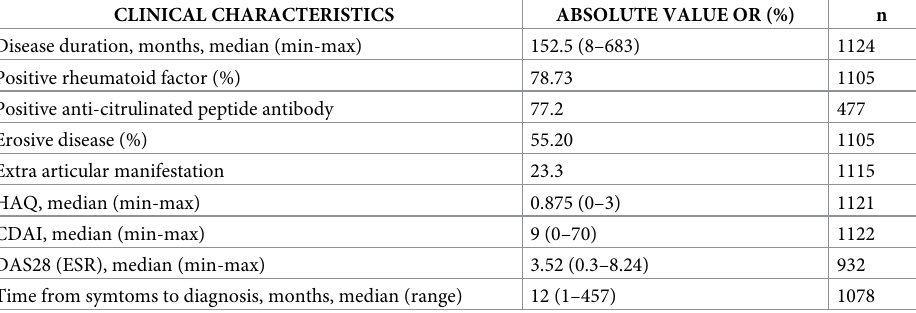
Table 1. Clinical characteristics of the patients with RA in the REAL study